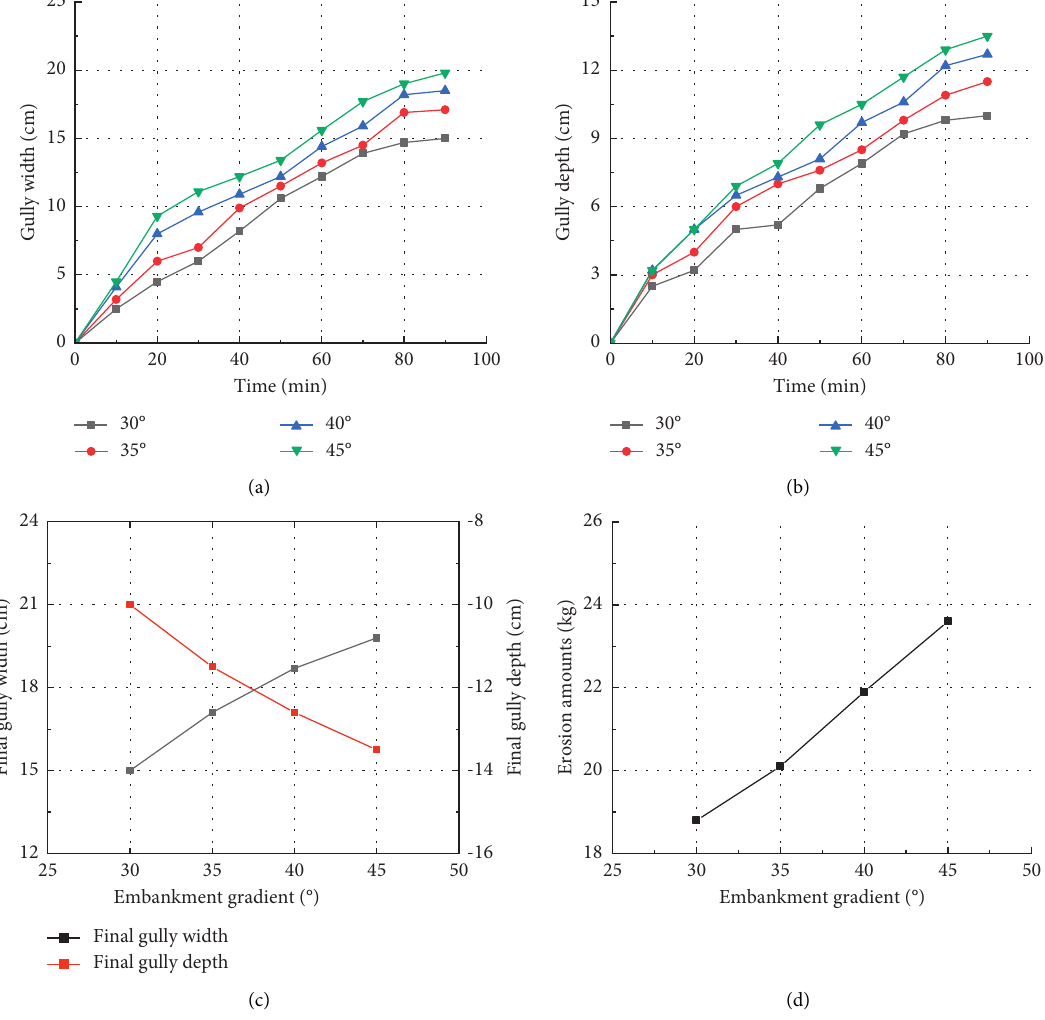
Figure 8: Effect of embankment erosion under different rainfall intensities: (a) gully width changes with time; (b) gully depth changes with time; (c) final gully width and depth; (d) final erosion amount.